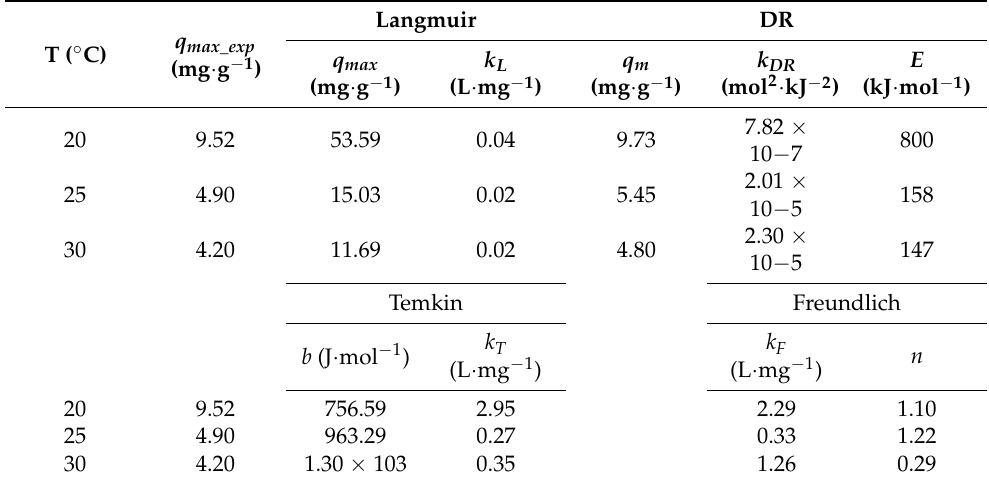
Table 5. Parameters of the isothermal adsorption models at different temperatures.